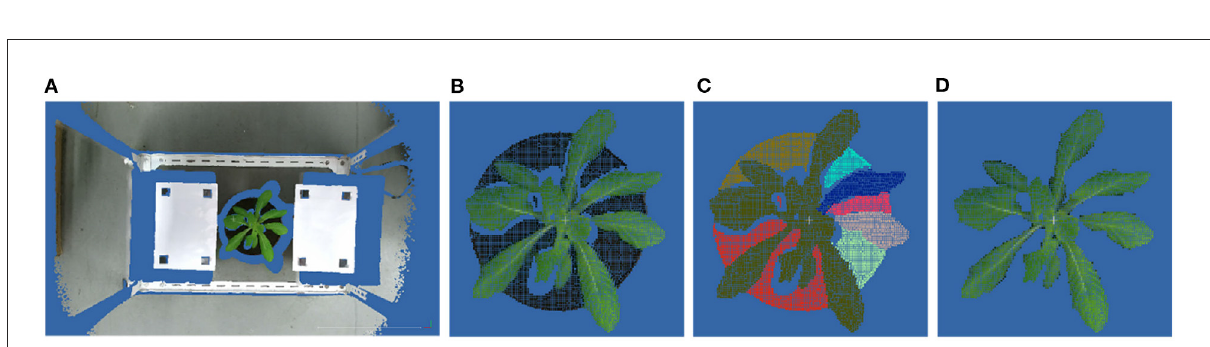
FIGURE2 Point cloud preprocessing results. (A) The original point cloud obtained by ToF camera from the top view. (B) ROI point cloud obtained by pass- through filter. (C) Plant and soil point clouds obtained by color-based region growing segmentation. (D) Plant point cloud after